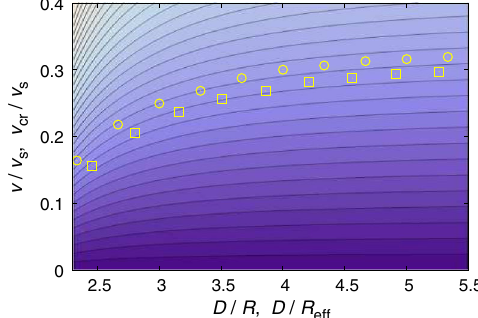
FIG. 5. Contourlinesshowthemaximumflowvelocity u asa max , obtained from Eq. (10). The contour function of D=R and v=v s ¼ 0 : 05 ; 0 : 1 ; 0 : 15 ; 0 : 2 ; . . . , from below. The =v lines indicate u max s for vortex-dipole nucleation plots show the critical velocity v cr , which is obtained by simulations as in Fig. 4. Here versus D=R eff R is the radius of the density hole produced by the potential. The eff =(cid:2) Þ ¼ ð 5 ; 9 : 5 Þ beam waist and the effective radius are ð d=(cid:2); R eff for the circles and (10, 18) for the squares.